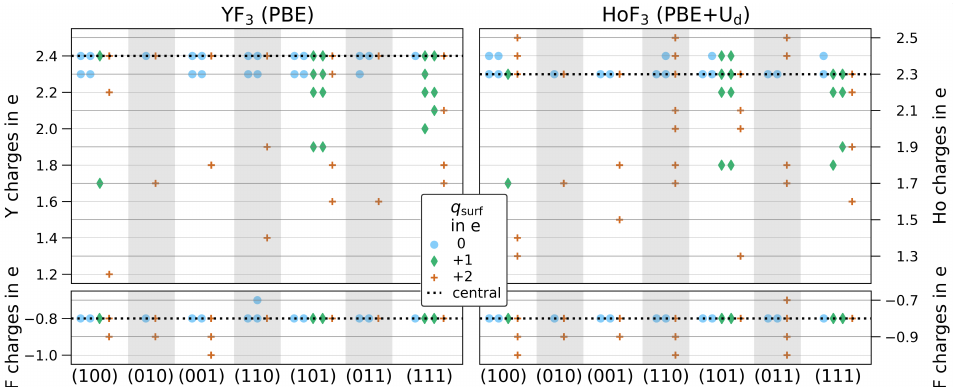
Figure 5. Bader charges rounded to 0.1 e for all slabs of YF 3 (left, PBE) and HoF 3 (right, PBE+U d /3 eV/4f-in-core): the Bader charges of the bulk are highlighted by the dotted line (Y: 2.4 e, Ho: 2.3 e, F: − 0.8 e). Terminations are differently colored by their formal surface net charge ( q surf ) in e for 0 (blue cycle), + 1 (green diamond) and + 2 (orange